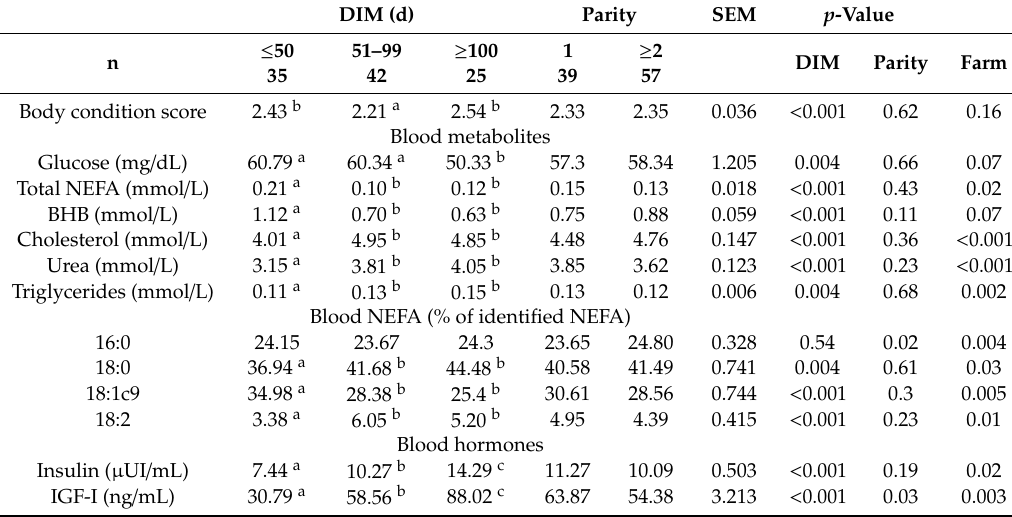
Table 3. Influence of days in milk, parity and farm on blood fatty acid concentrations, metabolites and hormones in early lactation Holstein